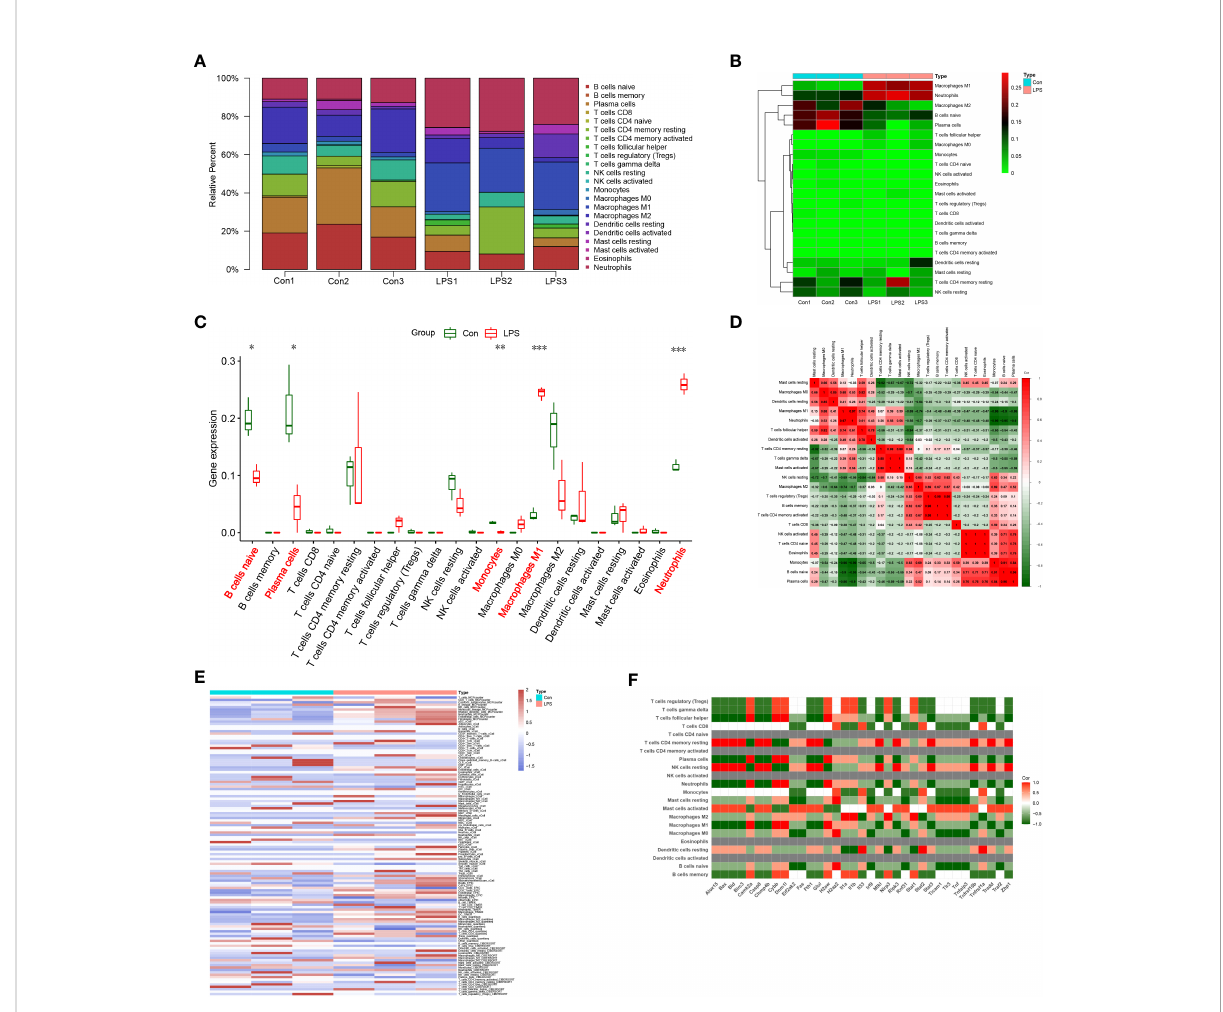
FIGURE 8 Immunocyte in fi ltration changes in the heart tissues of the SIMD group mice. (A) CIBERSORT analysis results show the proportions of 22 different immune cell types in the heart tissues of the control and SIMD group mice. (B) Heatmap of the 22 different immune cell types in the heart tissues of the control and SIMD group mice. (C) Differences in the in fi ltration levels of different immune cell types between the control and SIMD group mice. Red boxes denote SIMD samples, green boxes denote SIMD samples. (D) Cor-heatmap shows the relationship between the 22 different immune cell types. (E) The thermogram shows the variation in the abundance of different immune cell types in the control and SIMD groups based on multiple algorithms. (F) The correlation between differentially expressed necroptosis-related genes and different types of immune cells in SIMD. *p < 0.05, **p < 0.01, ***p <